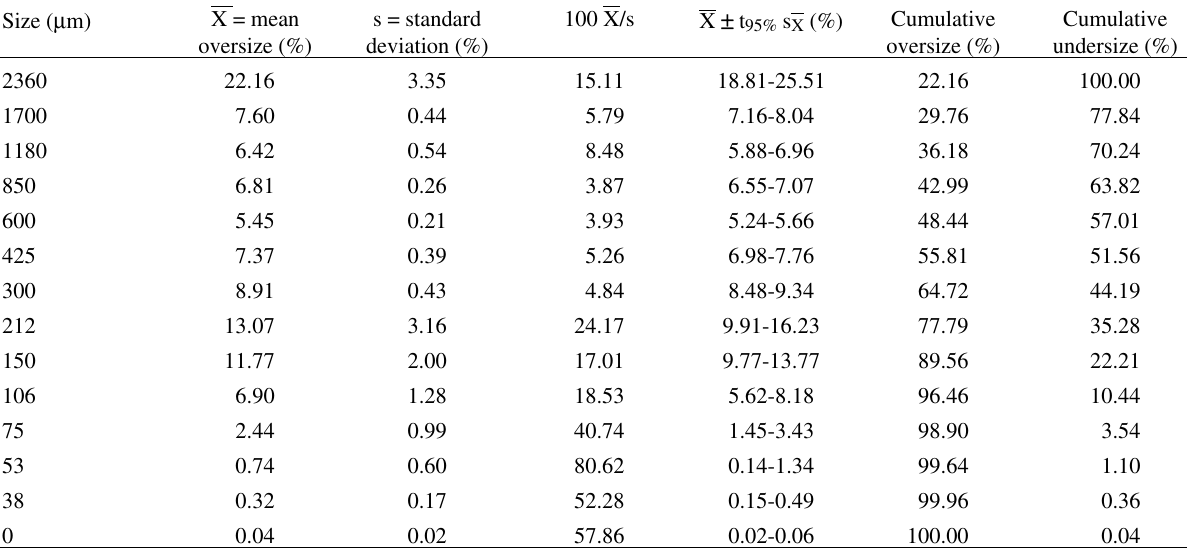
Table 1. Product size distribution analysis.